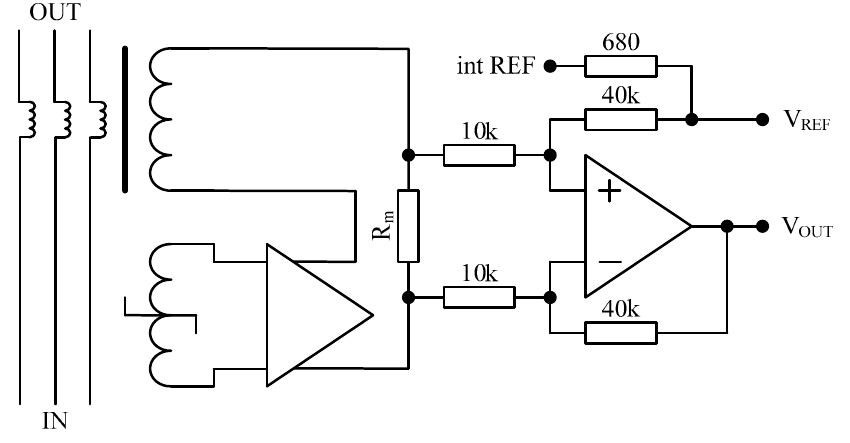
Figure 2. Electric scheme of the CASR 25-NP (LEM, USA) current transducer [4].